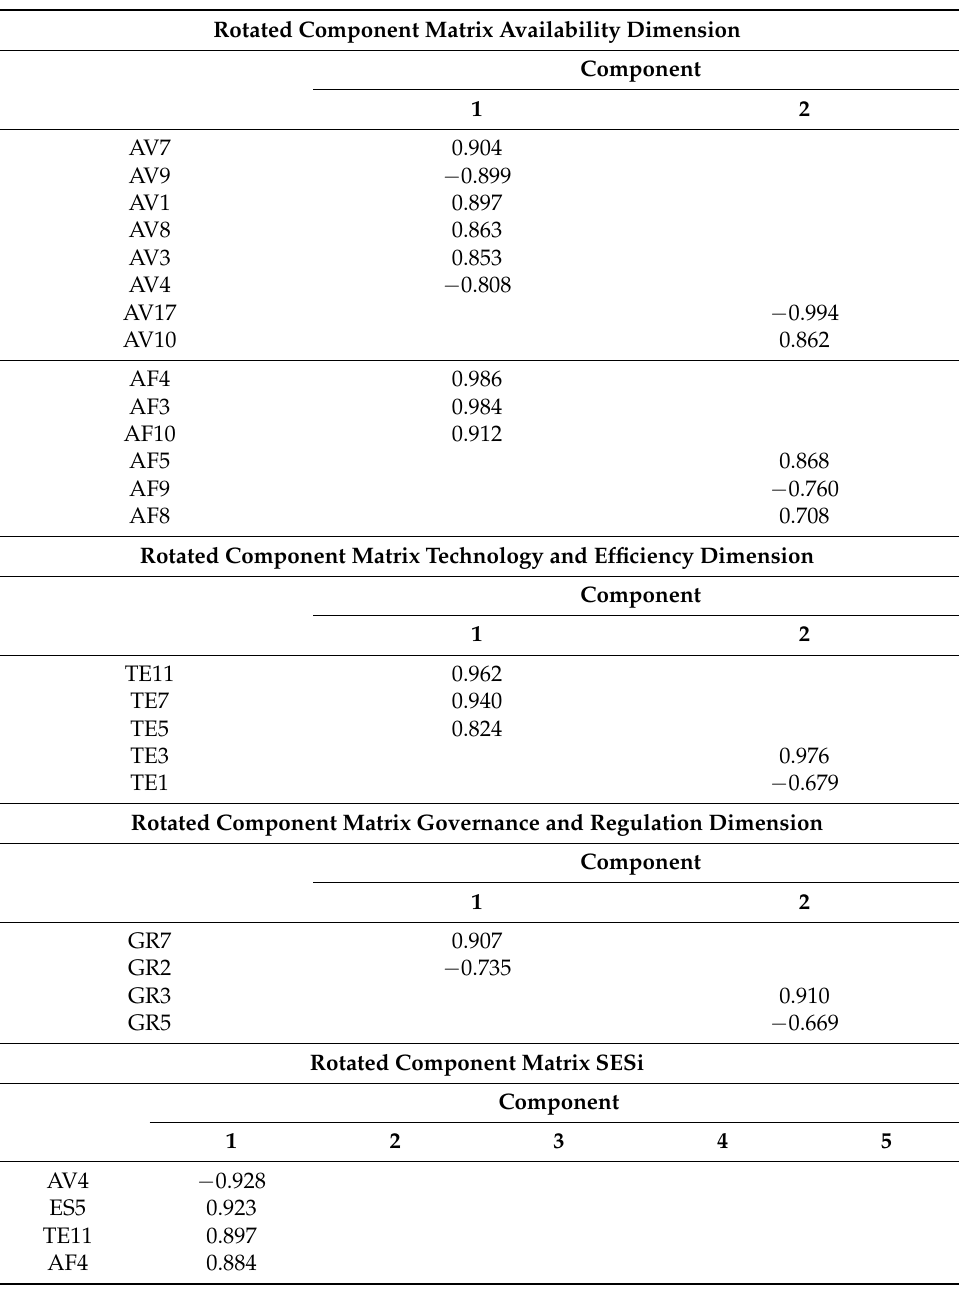
Table 3. Varimax-based extraction of